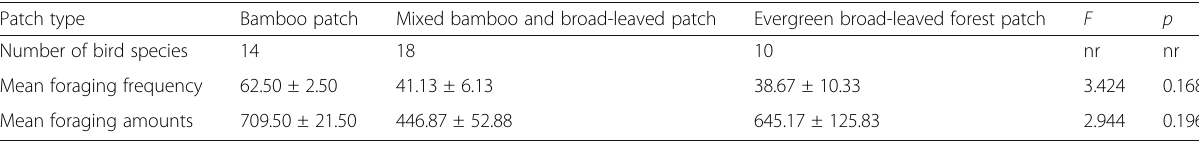
Table 2 Comparison of bird species and their foraging behaviors on each individual of Taxus chinensis across different habitat patches in the patchy habitat of yew ecological garden, Fujian Province, southeast China Patch type